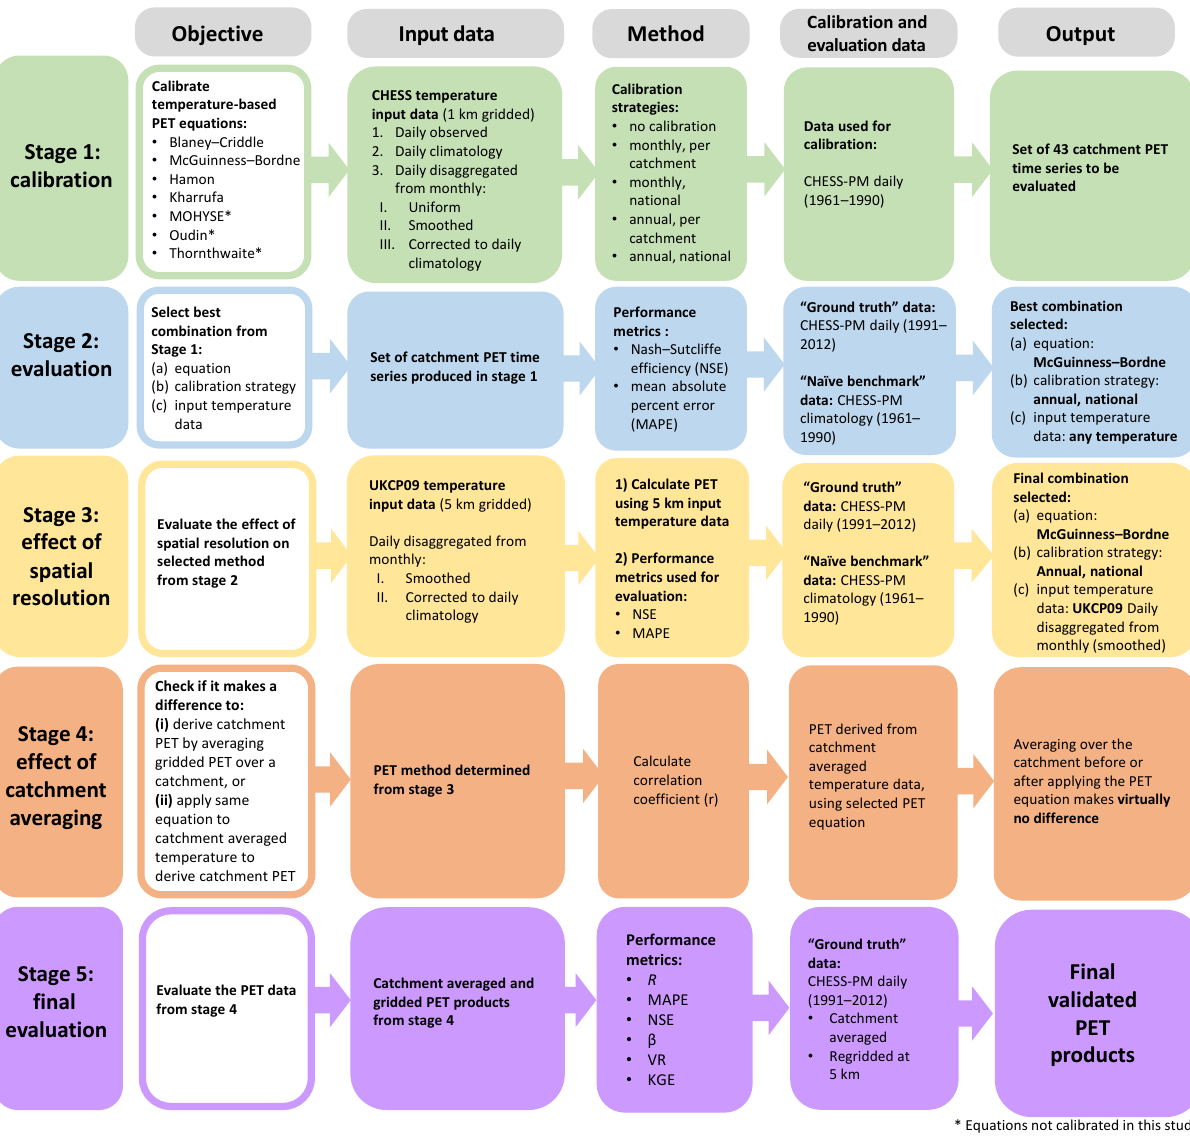
Figure 1. Work flow diagram of the evaluation procedure of the PET equations and final PET gridded product. This process was made in five stages: in stage 1, the equations were calibrated using different calibration strategies and different input temperature data; in stage 2, the multiple combinations of PET equation/calibration approach/temperature input data were evaluated; in stage 3, the effect of spatial resolution of the input temperature data was assessed. These first three stages led to the selection of PET equation, calibration strategy and input dataset used to produce the final gridded PET product. In the fourth stage, the effect of calibrating the equations at the catchment scale was investigated; and finally, in stage 5, a final evaluation of the new gridded PET product was carried out both at the catchment scale and at the grid scale. Stages 1, 2 and 3 used the set of 43 catchments shown in Fig. 2a, whereas stages 4 and 5 used the full set of 306 evaluation catchments shown in Fig.